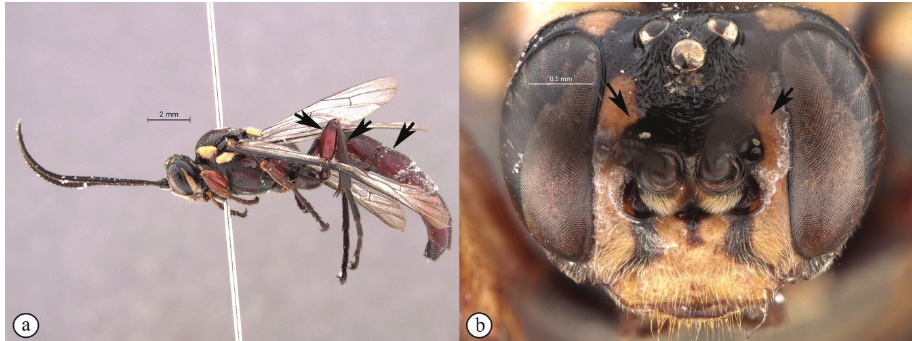
dish-brown (a); antennal scrobe less extensive, ending an ocellar diameter